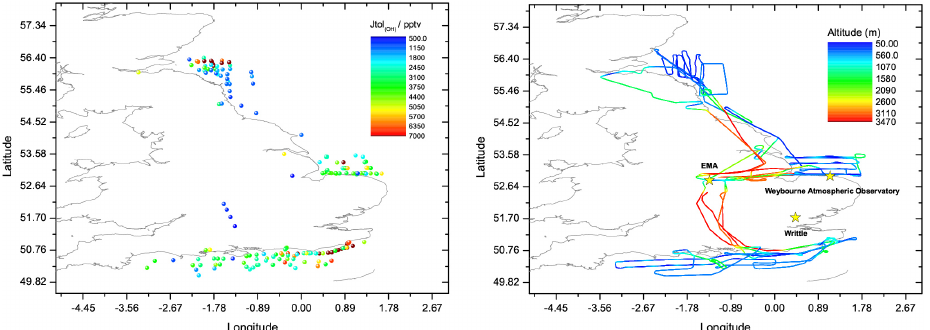
Figure 1. WAS locations analysed using GC × GC-TOF-MS during the RONOCO campaign. Left: spatial distribution of WAS bottles, coloured by their respective total [EQ Tol ] OH value. Right: flight Tracks for the five RONOCO flights in which GC × GC-TOFMS analysis was performed, coloured by altitude. EMA=East Midlands